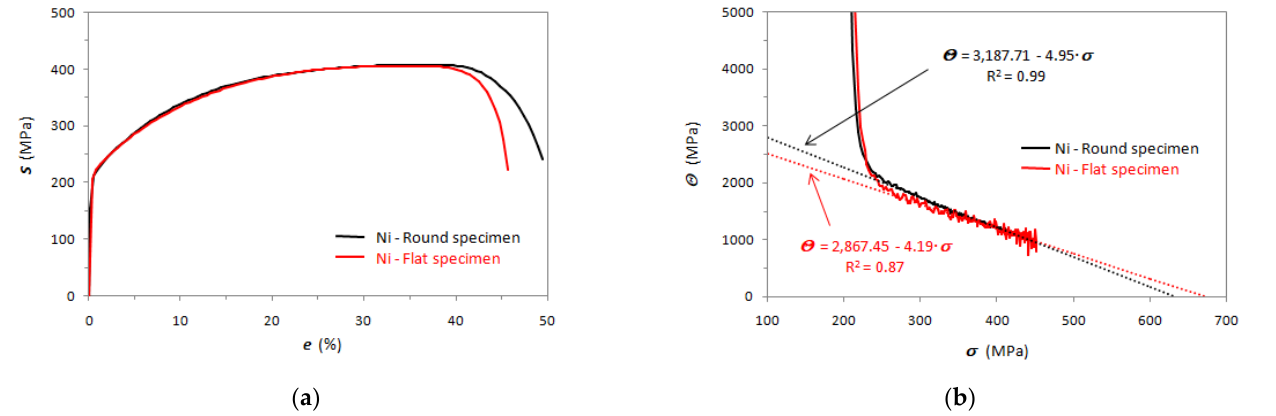
Figure 23. Ni polycrystalline tensile plastic behavior comparison between round and flat tensile specimens data: ( a ) engineering stress–strain flow curves; ( b ) differential data (true strain hardening rate Θ vs. true stress σ ) from the tensile flow curves in ( a ) and differential Voce equation fittings.